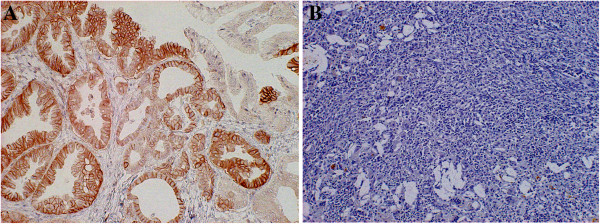
Immunohistochemical staining of tissue from a 79-years old man with extrahepatic cholangiocarcinoma (A) and a 66-years old woman with Xanthogranulomatous chlecystitis as control group (B). Immunostaining of LAT1 demonstrates a membranous immunostaining pattern in cholangiocarcinoma, but there was no evidence of LAT1 staining in xanthogranulomatous chlecystitis.